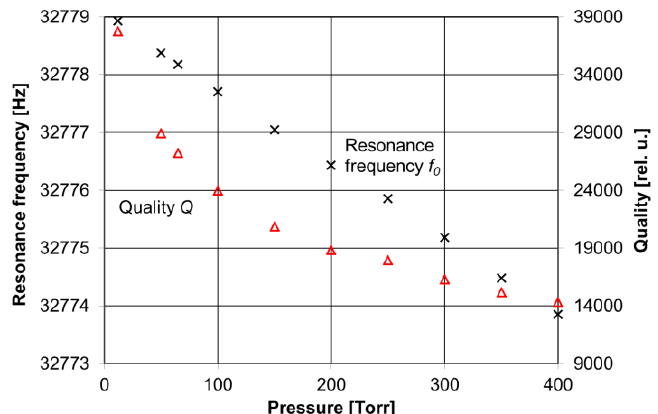
Figure 7. QTF resonance frequency and quality factor measurements as a function of pressure inside the optical cavity.